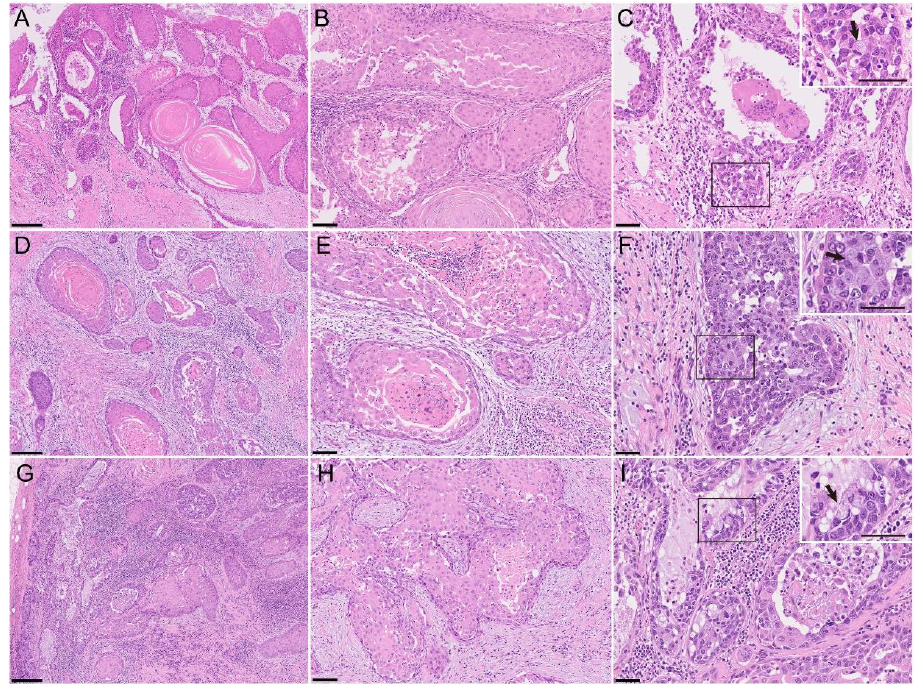
Figure 2. Histology of ASC with the acantholytic feature in the primary ( A – C ), recurrent ( D – F ), and metastatic ( G – I ) lesions. Hematoxylin – eosin (HE) staining ( A – I ). Arrows, mucin-containing cells. Bars, 250 μm ( A , D , G ), 100 μm ( B , E , H ), and 50 μm ( C , F , I ). In the primary mandibulectomy speci-